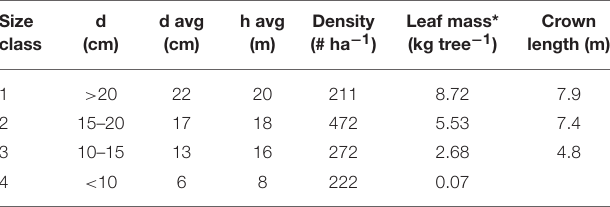
TABLE 1 | Diameter (d), height (h), and stocking density at the study site divided into different size